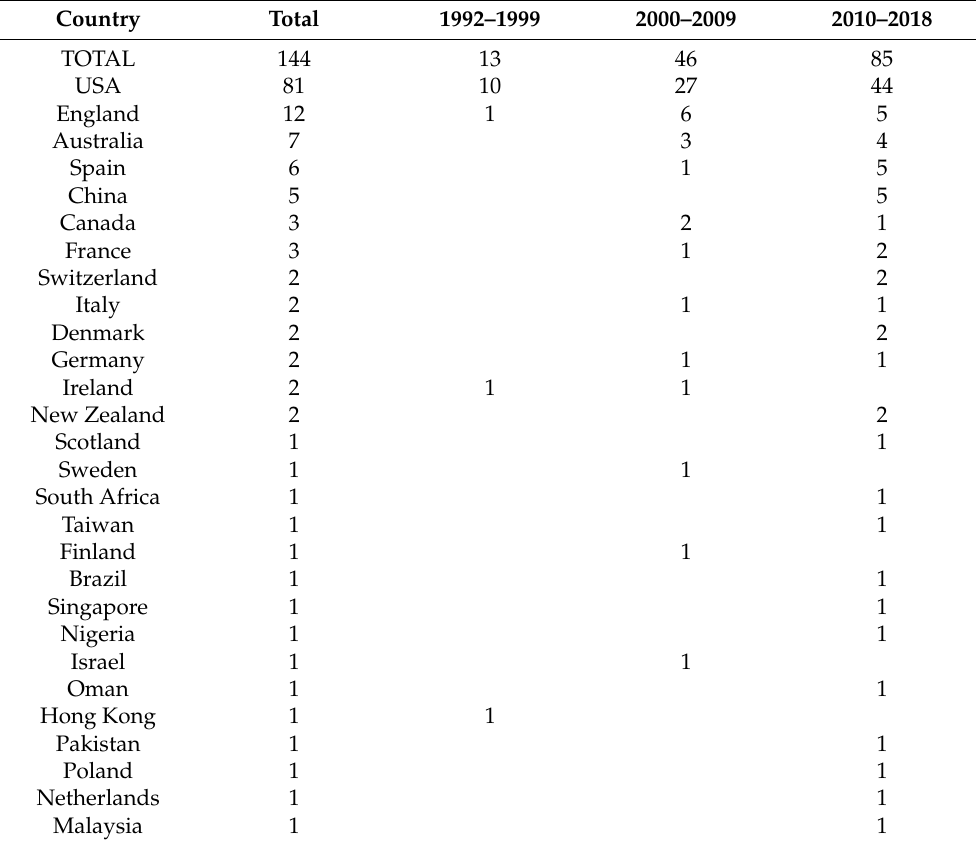
Table 5. Bibliographic production by country and